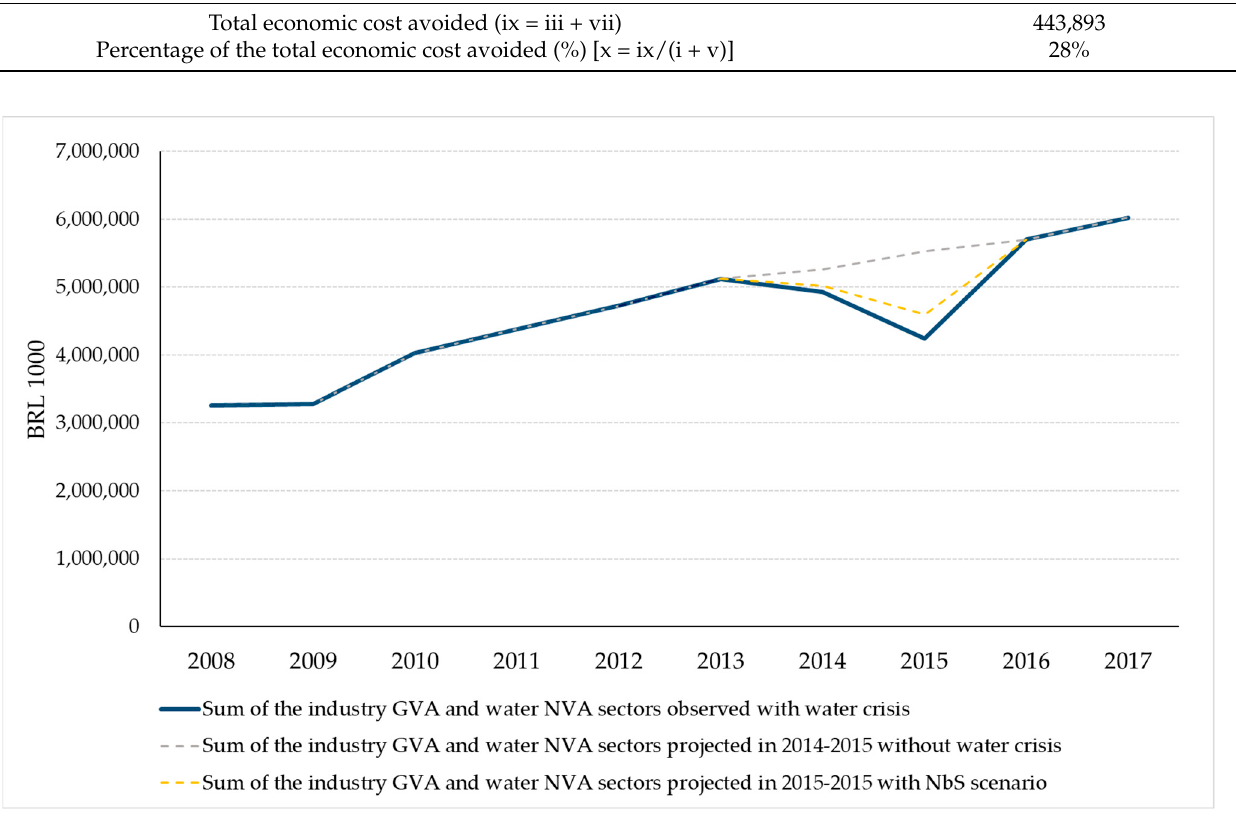
Figure 6. Sum of observed industrial GVA and water sector NVA (solid blue line); projected 2014–2015 without water crisis (dashed grey line); projected 2014–2015 with NbS scenario (dashed yellow line).